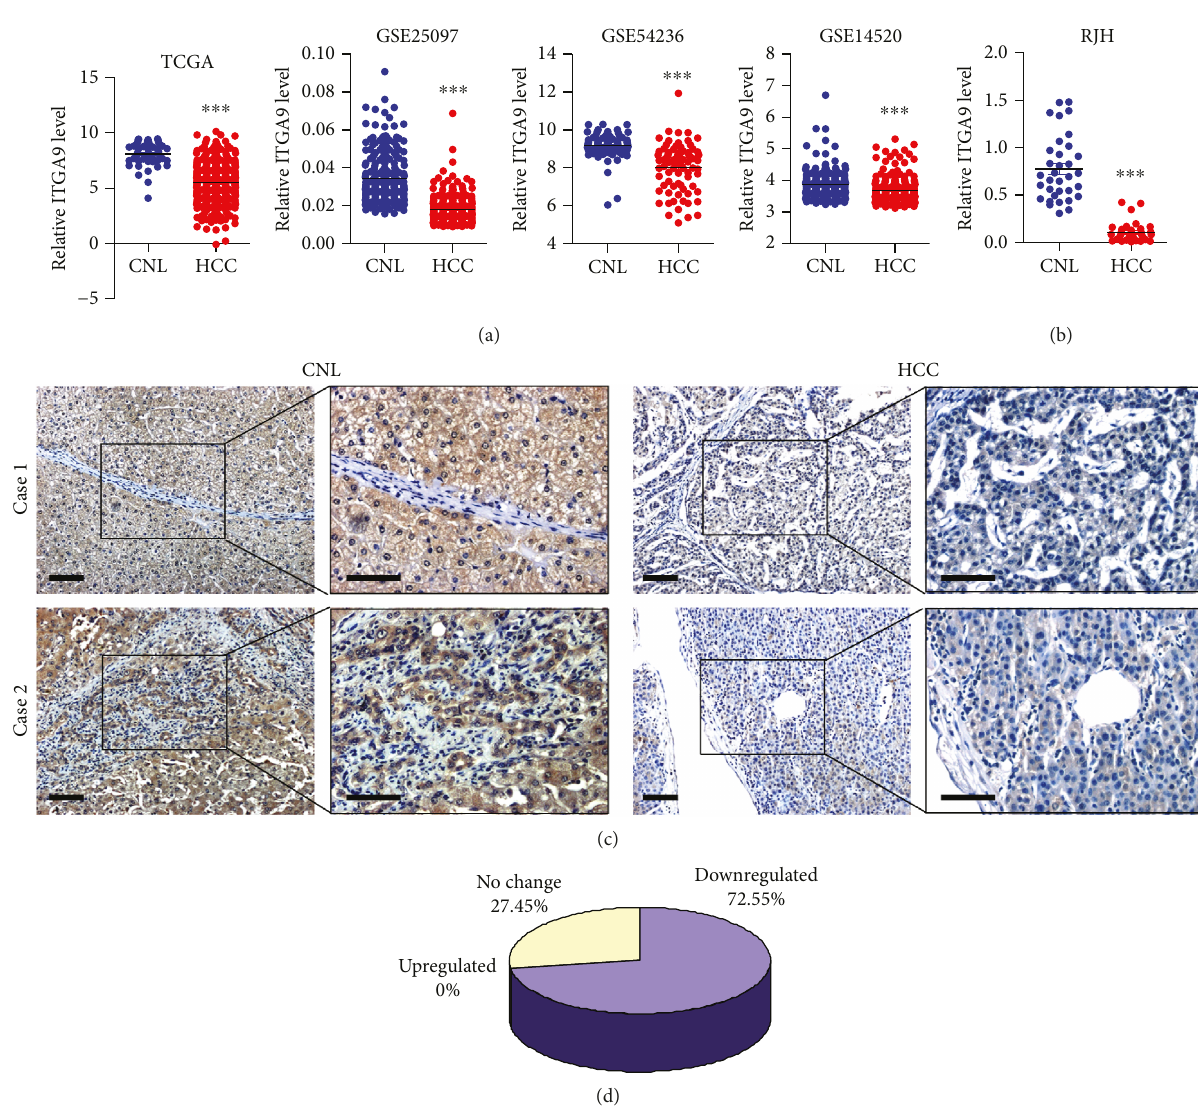
Figure 1: Analysis of ITGA9 expression in HCC tissues. (a) Analysis of ITGA9 expression in HCC mRNAseq data from the TCGA database ( n = 372 ) and 3 independent HCC microarray datasets from the GEO database (GSE25097, n = 268 ; GSE54236, n = 161 ; and GSE14520, n = 225 ). Values are means ± SEM. ∗∗∗ P < 0 001 . (b) Expression levels of ITGA9 in CNL tissues and HCC tissues by qPCR for 34 pairs of the CNL/HCC tissues from RJH. Values are means ± SEM. ∗∗∗ P < 0 001 . (c) Representative images of ITGA9 immunohistochemical staining in 131 paired HCC and CNL tissues. Scale bars, 100 μ m. (d) Graphical analyses of (c) showing the decreased ITGA9 level in HCC patients compared to the paired CNL. Score of CNL > HCC: 72.55% ( n = 95 ), score of CNL=HCC: 27.45% ( n = 36 ), and score of CNL < HCC: 0% ( n = 0